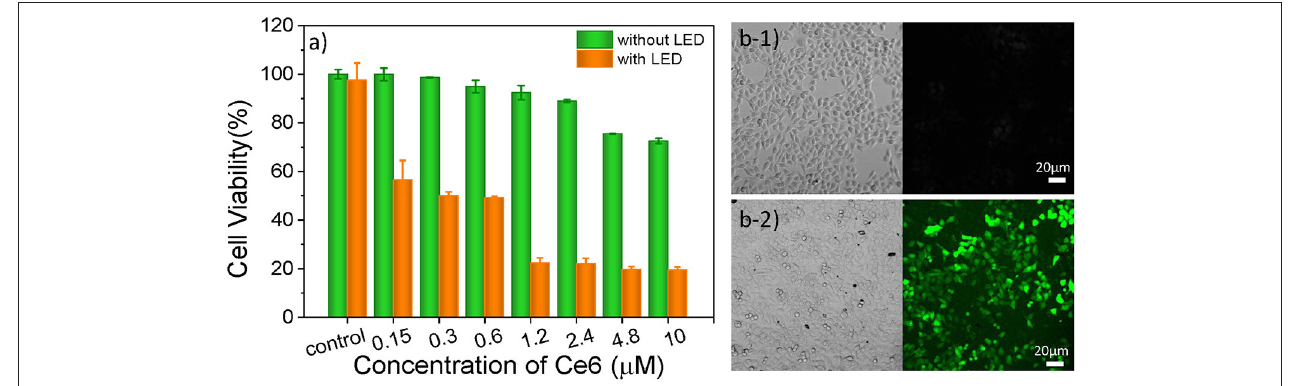
FIGURE 3 | (a) Cell viabilities of B16 cells incubated with Ce6 under different concentrations for 12h before and after the irradiation of a 650nm lamp (18 mW/cm 2 ) for 5min. Bright-field and confocal fluorescent images of Ce6 (1.2 µ M) treated B16 cells stained with DCFH-DA (10 µ M) before (b1) and after (b2) they were treated with 650nm LED (18 mW/cm 2 ) for